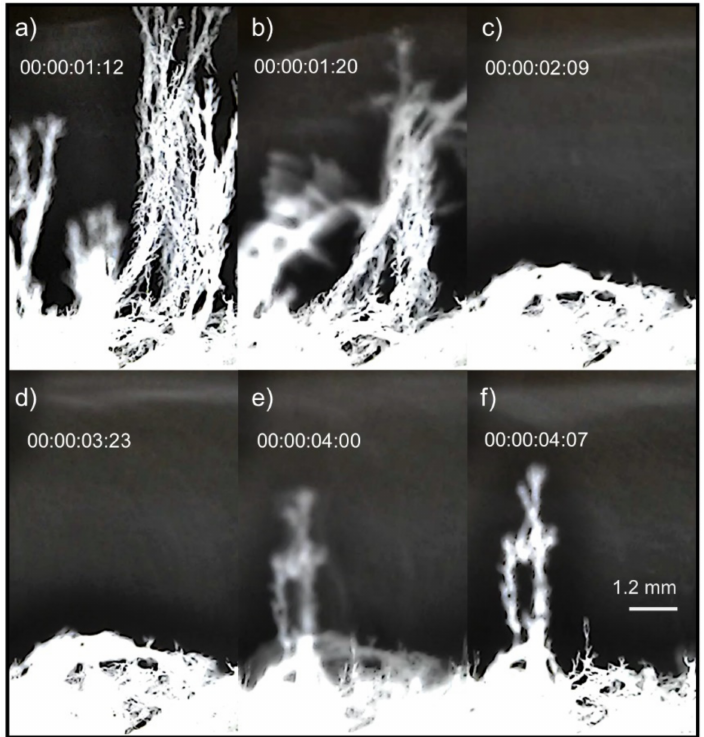
Figure 8. Sets of successive frames from the same area, showing the effect of switching the electrode voltage off and on. ( a ) Just before switching off; ( b ) just after switching off: dendrites are collapsing; ( c ) collapsed dendrites; ( d ) just before switching on again; ( e ) just after switching on, some dendrites and needles upraised under the field; ( f ) 400 ms after switching